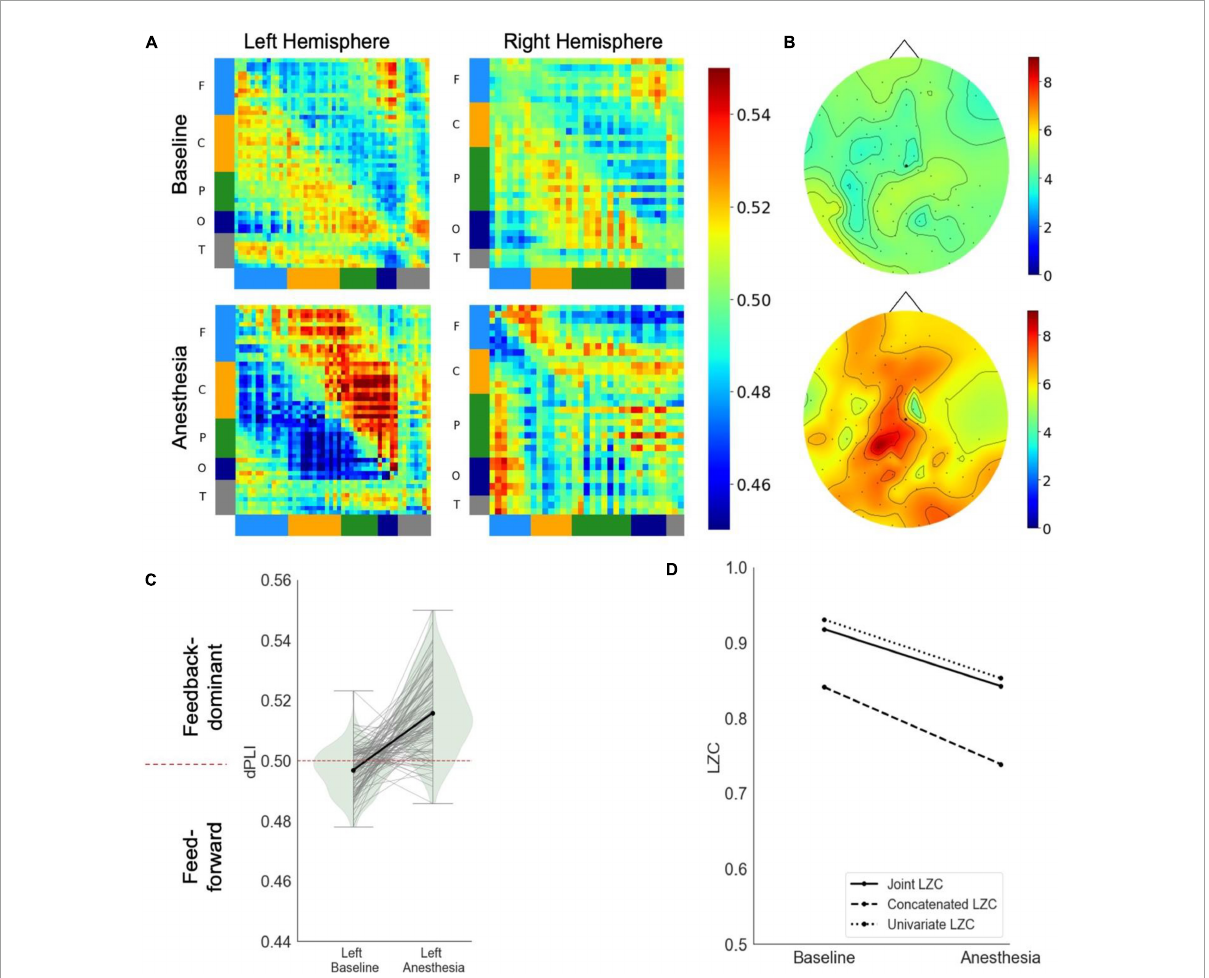
FIGURE2 Case 2 (A) directed functional connectivity (dPLI) within the right and left hemisphere during baseline and anesthesia. Electrodes are ordered per region: F, frontal; C, central; P, parietal; T, temporal; O, occipital (B) network hubs during baseline and anesthesia. (C) Directed functional connectivity (dPLI) between frontal and parietal regions within the left and right hemisphere. Light gray lines represent individual electrodes, black lines represent the mean. (D) Three types of Lempel-Ziv complexity and its propofol-induced